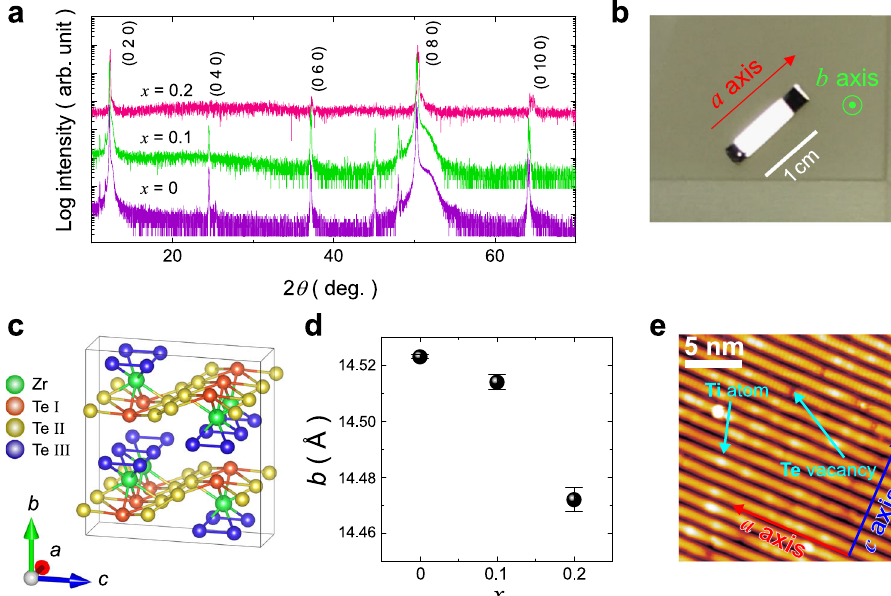
Fig. 1 Material characterization of pristine and Ti-doped ZrTe 5 . a X-ray diffraction patterns of single crystals. All peaks correspond to the (0k0) plane. b Micro-optics image of a typical single crystal. The single crystals naturally grow along the a axis. c The crystal structure of ZrTe 5 . The van der Waal bonding is along the b axis. d Estimated lattice constant of b . The error bars represent the standard errors of the linear fi t of Bragg ’ s law. e Scanning tunneling microscopy image of x = 0.1 crystal as a representative. Clear stripe patterns are shown in the ac plane.